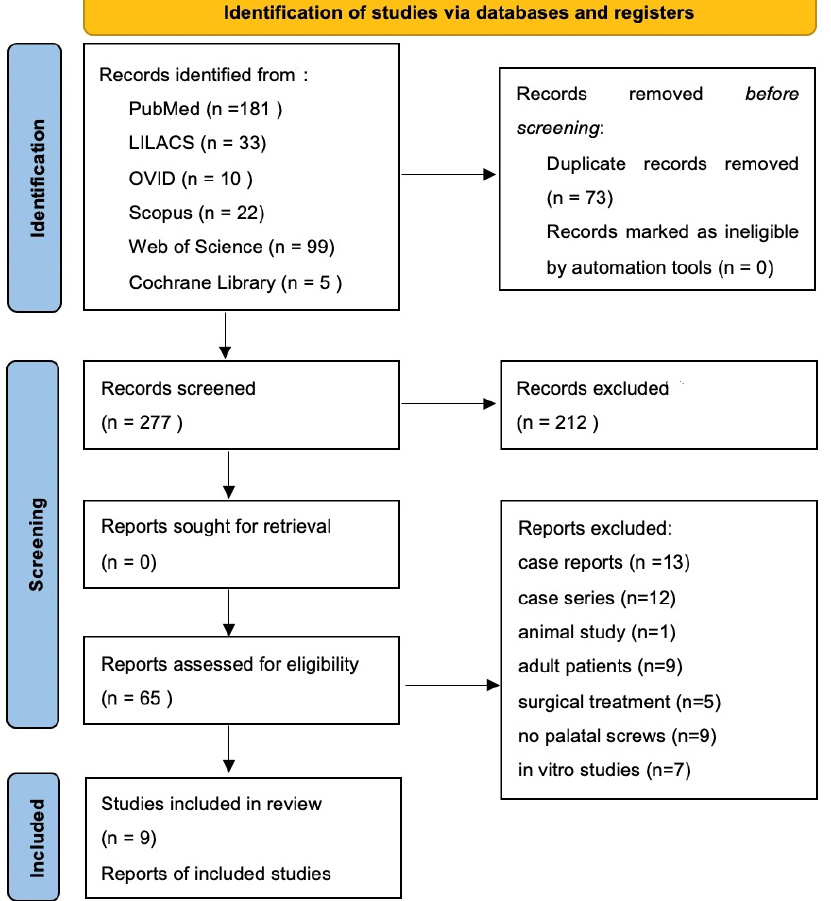
Figure 2. Flow diagram of the selection of the studies (according to PRISMA 2020 flow diagram) [17].